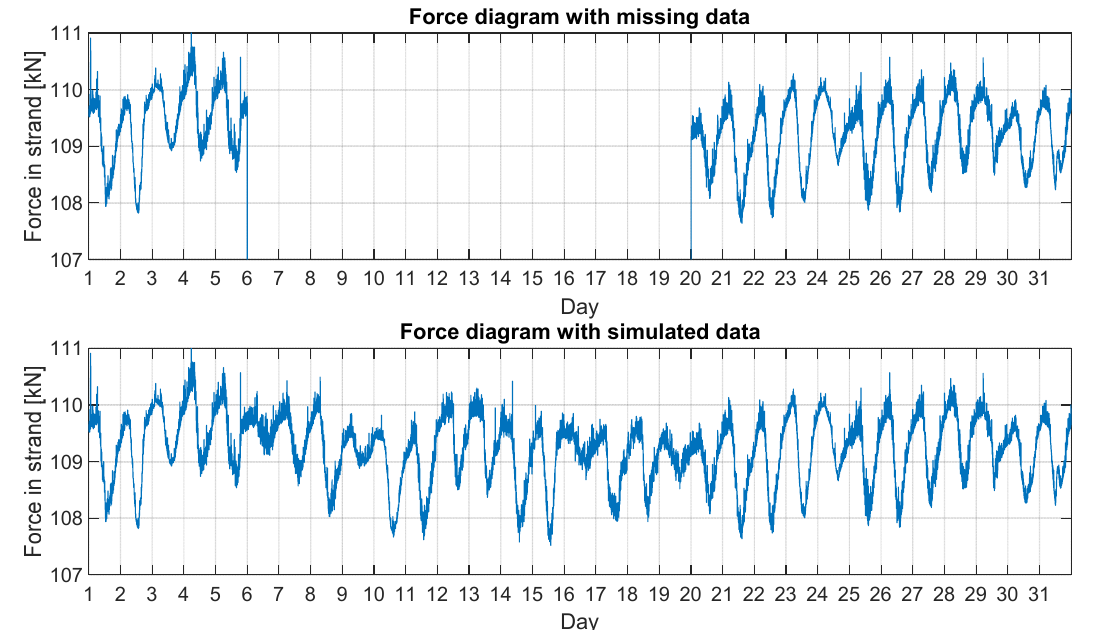
Figure 21. LW-16 force chart in July 2016. Upper chart with missing data and lower with simulated one.